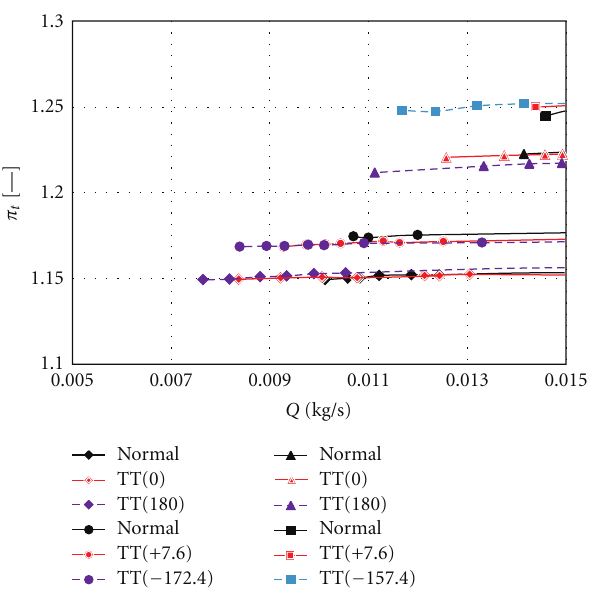
Figure 6: Performance characteristics at low flow